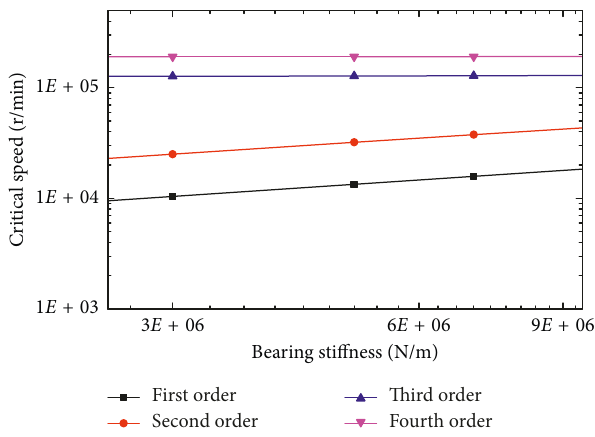
Figure 6: The critical speed changing with gas film